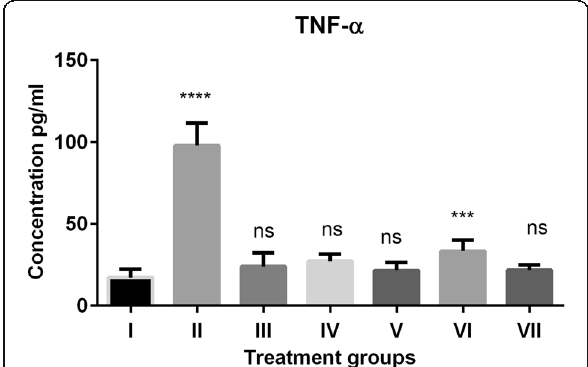
Fig. 5 Effect of grapefruit juice (GFJ) and aripiprazole (ARI) on oxidative stress induced by H 2 O 2 by TNF- α levels. TNF- α concentration is expressed as pg/ml ( n =10 The treated groups were compared to control group. **** P <0.0001, *** P <0.001, ns: non-significant. # Group I: Control; Group II: H2O2 treated; Group III; ARI treated; Group IV GFJ treated; Group V: GFJ and H 2 O 2 treated; Group VI; ARI and H 2 O 2 treated; Group VII; ARI, GFJ and H 2 O 2